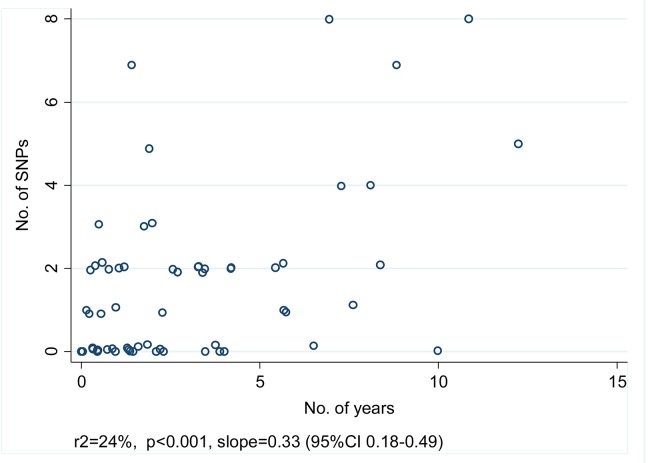
Number of SNPs by time interval between successive cases in 62 case-contact pairs with confirmed transmission.(Random noise has been introduced to allow those with identical numbers of SNPs to be visualised).